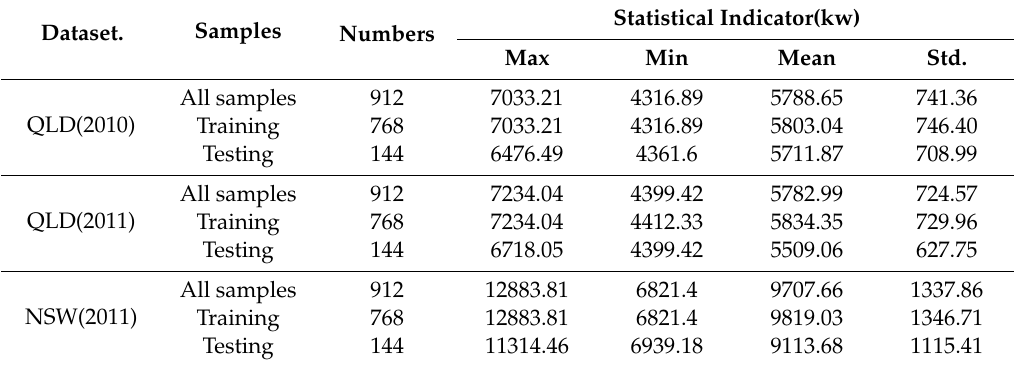
Table 1. Statistical indicators of experimental samples for three